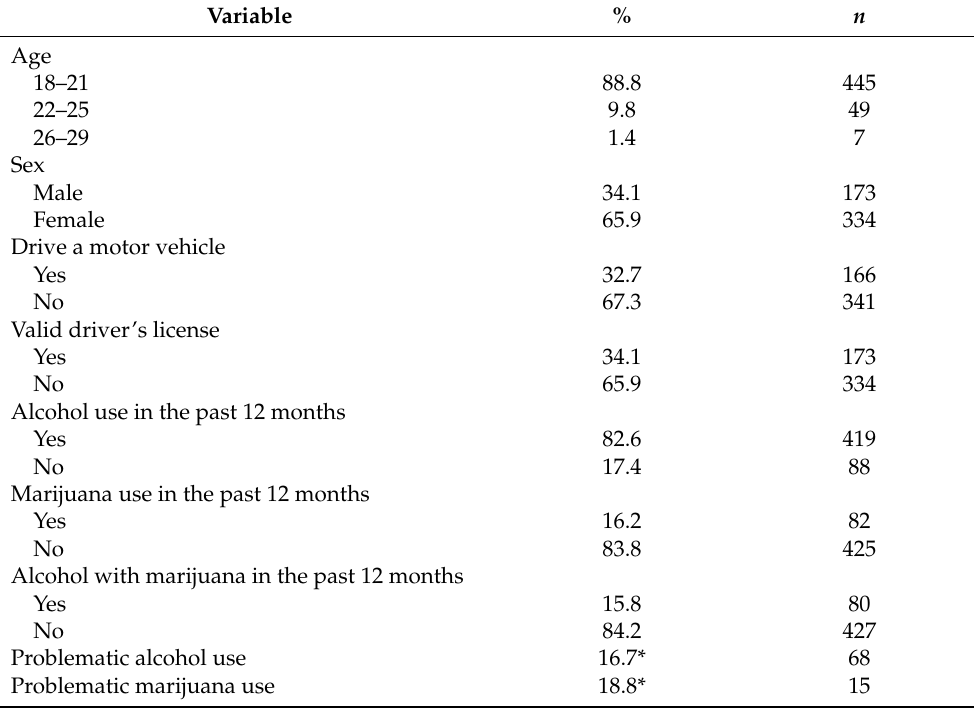
Table 1. Sociodemographic data 1